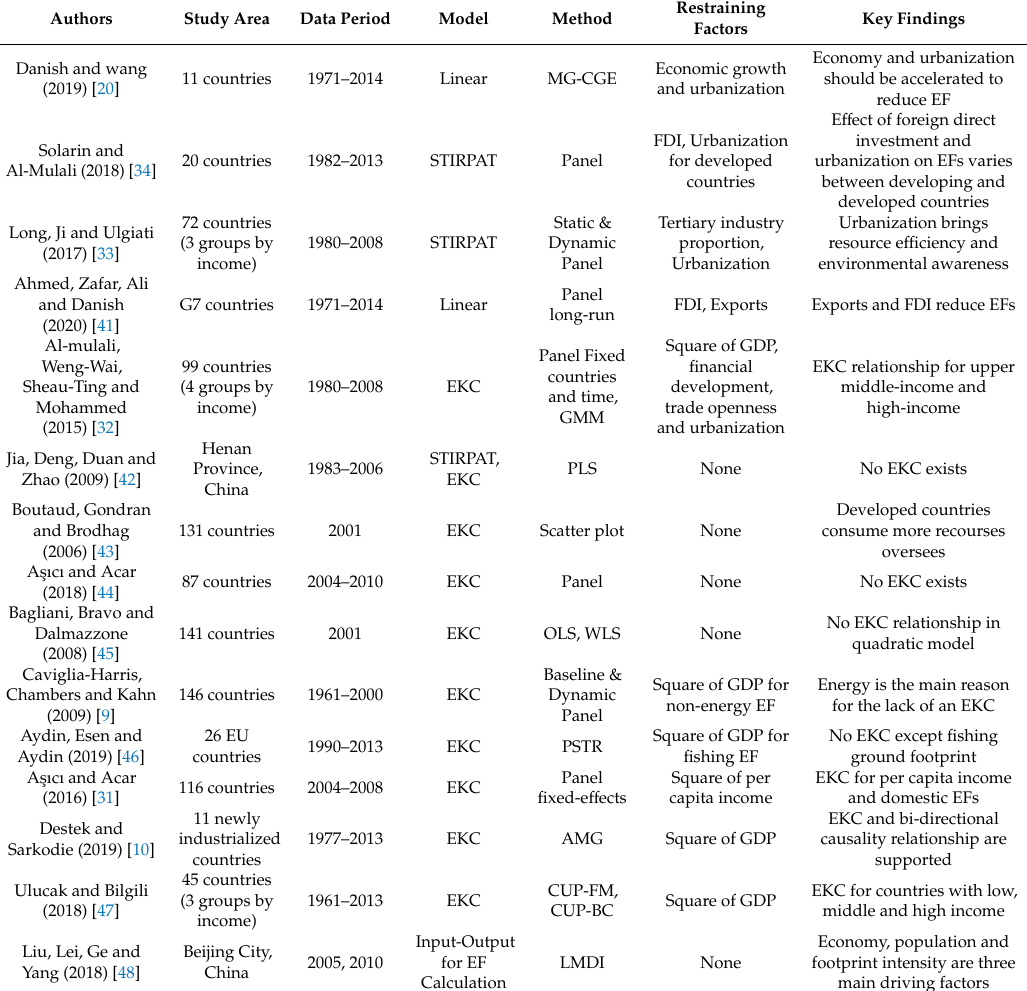
Table 1. Summary of the literature on restraining / influencing factors of ecological